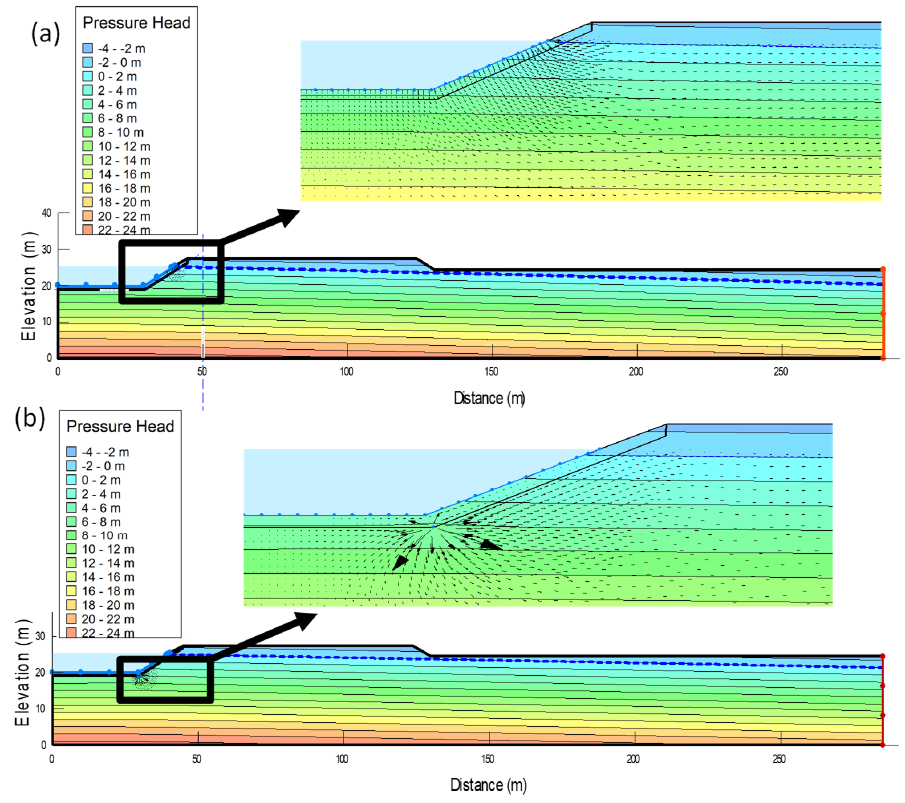
Figure 9. Canal seepage losses of different cracked liners, ( a ) without extraction and ( b ) with extrac- tion.